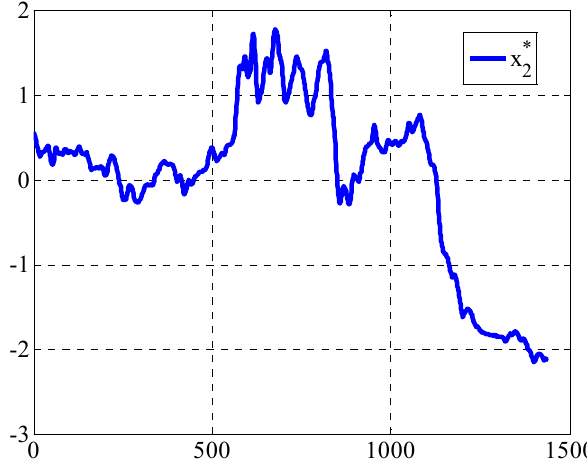
Figure 9. The standardized variable x ∗